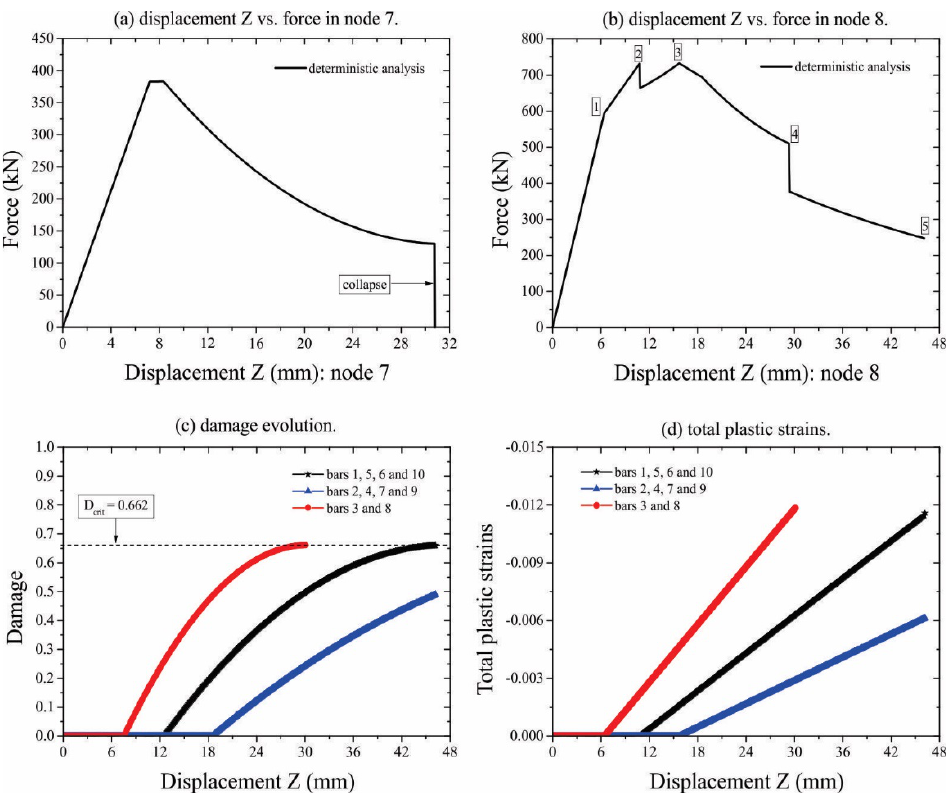
Figure 10. (a) Displacement Z vs. force in node 7; (b) displacement Z vs. force in node 8; (c) damage evolution and (d) total plastic strains in the bars: deterministic (mean value) analysis.